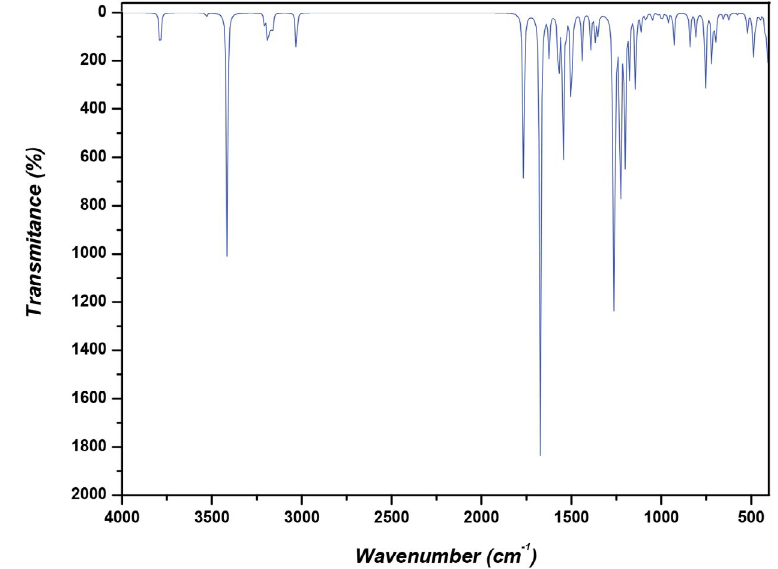
Figure 6. Theoretical IR spectra for